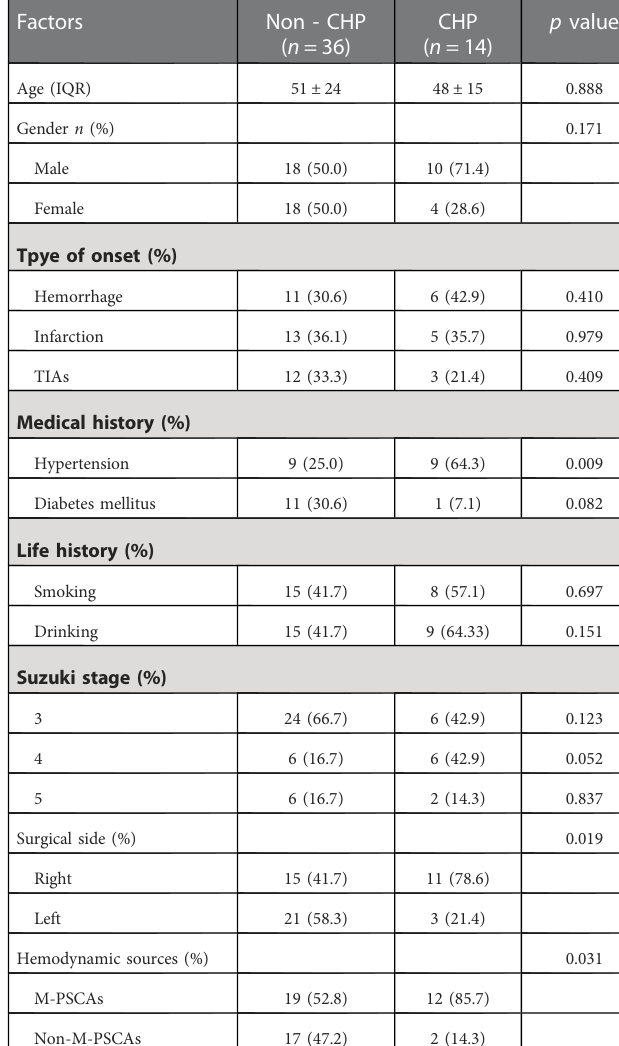
TABLE 2 Postoperative cerebral hyperperfusion syndrome in moyamoya disease in relation with clinical